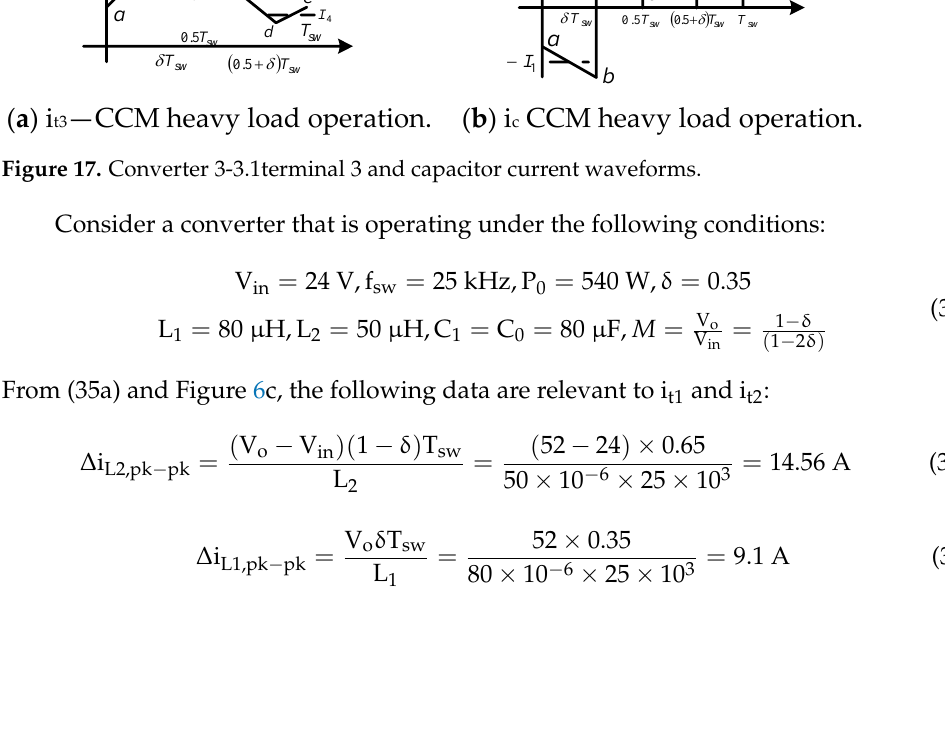
Current signals generated at terminals one, two, and three of converter 3-3.1 and and 17a,b, respectively.